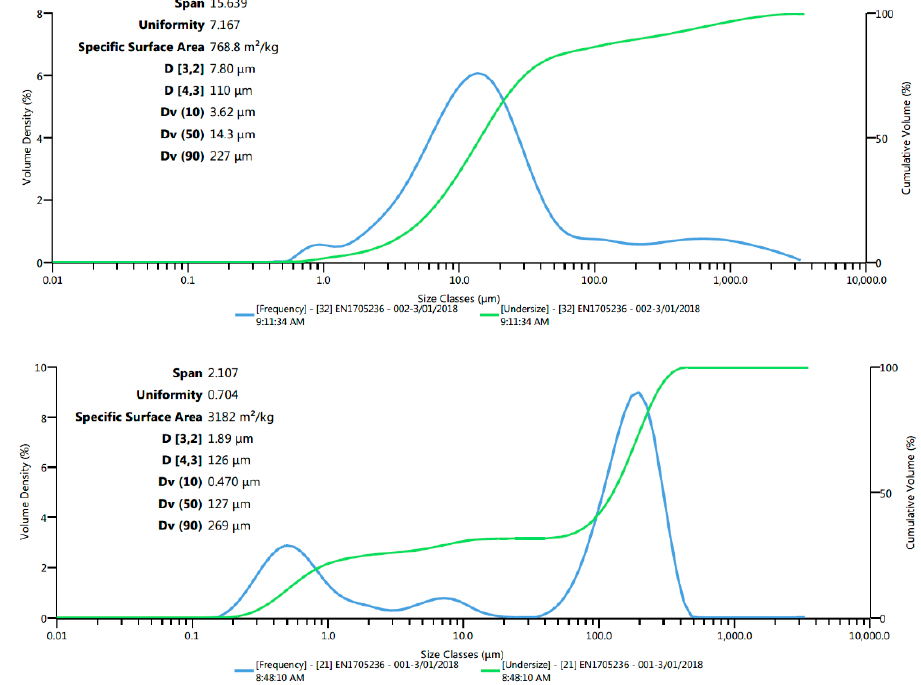
Figure 6. Particle size distribution of infiltration water ( top ) and backflushed water ( bottom ), both sampled on 13 December 2017 (event C in Table 3).